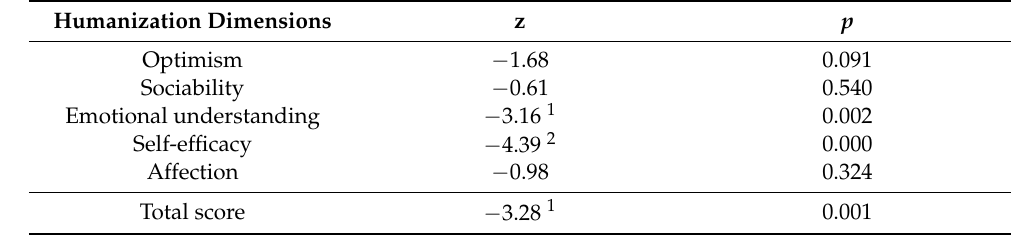
Table 2. Differences in mean scores for each humanization dimension and the total score obtained in HUMAS at baseline (pre-test) and after virtual simulation sessions (post-test) (N = 60). Humanization Dimensions